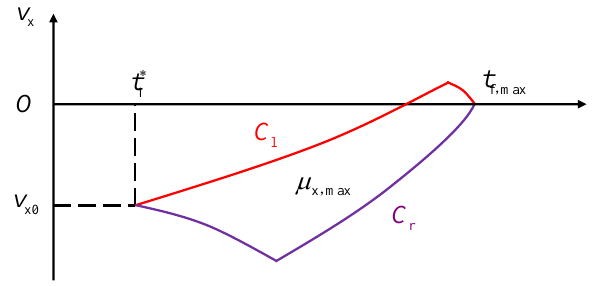
Figure 6. Two critical cases in the X direction.